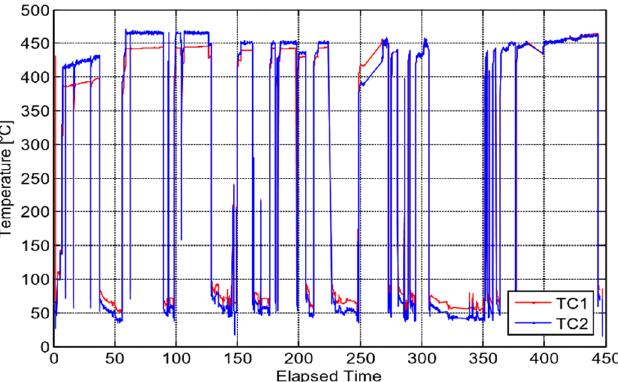
Figure 5. Temperature of bismuth titanate (BiTi) as a function of elapsed time (days) calculated from TC1 and TC2 thermocouples [14].